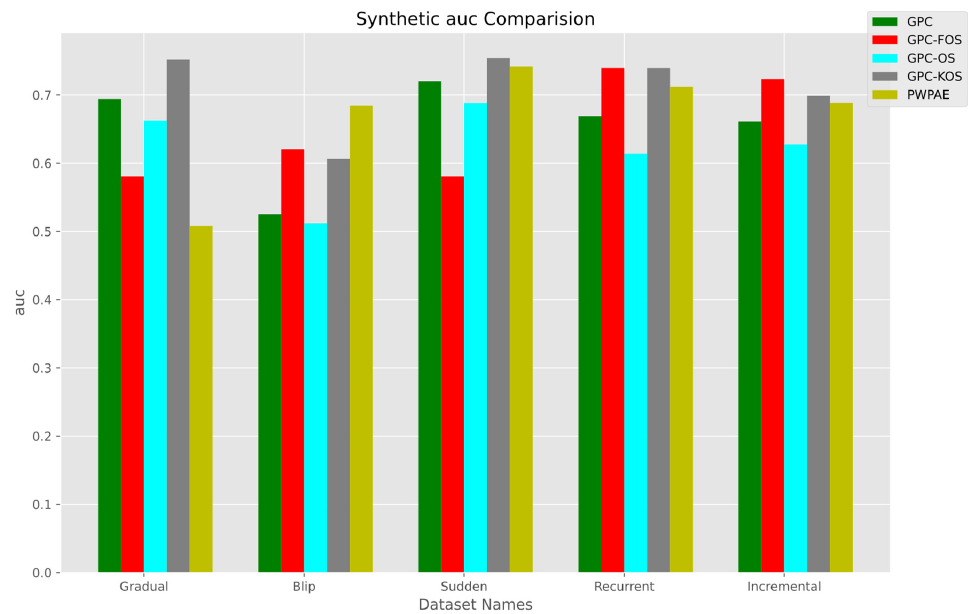
Figure 7. AUC of the incremental GPC (OS, FOS, KOS) variants and benchmarks (GPC, PWPAE) for synthetic data.